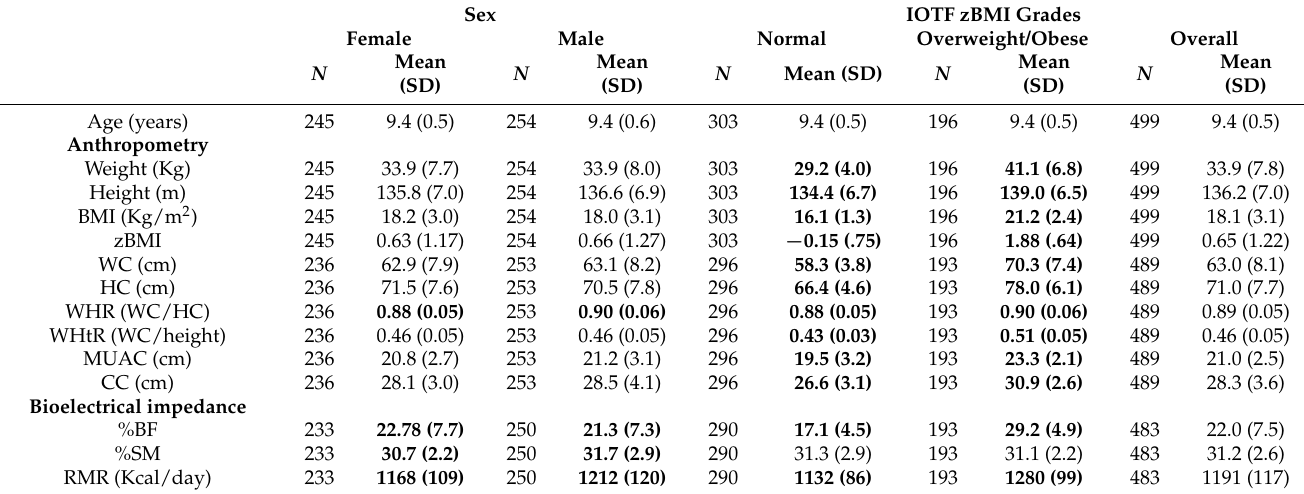
Bold values highlight the statistically significant differences between Female versus Male and Normal versus Overweight/Obese ( p < 0.05). Results include sample size (N), mean and standard deviation (SD). BF body fat,